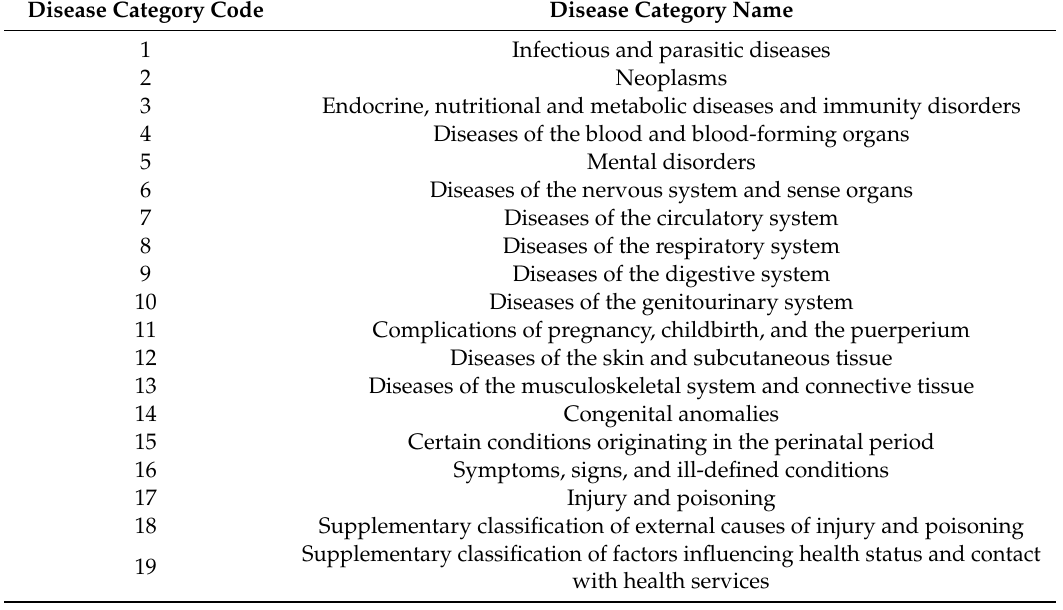
Table 2. List of disease categories. (Based on